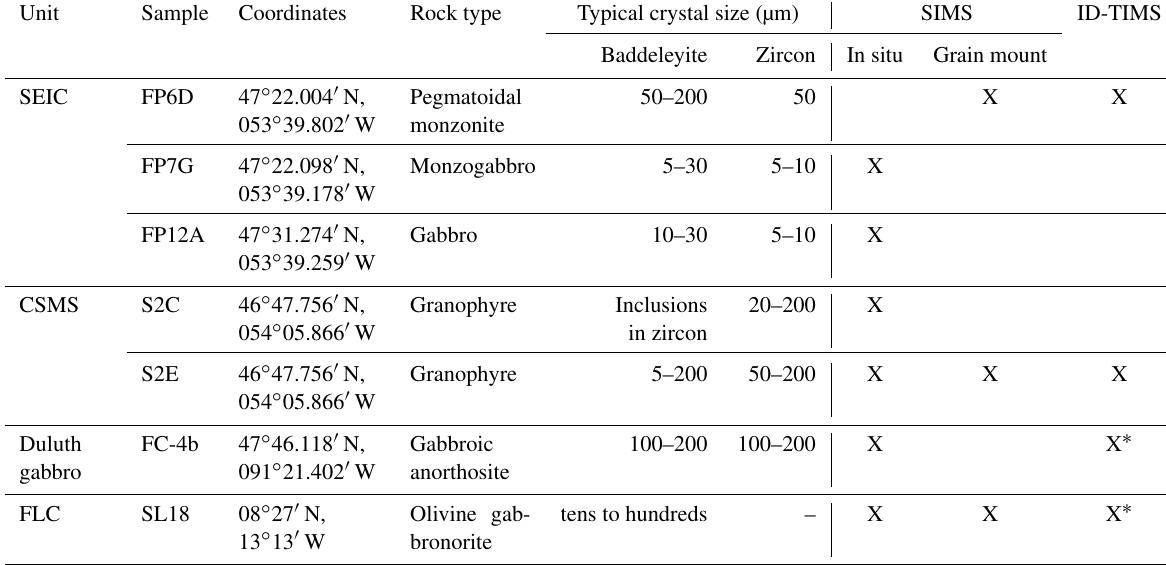
Table 1. Samples used for U–Pb geochronology. Unit Sample Coordinates Rock type Typical crystal size (µm) SIMS